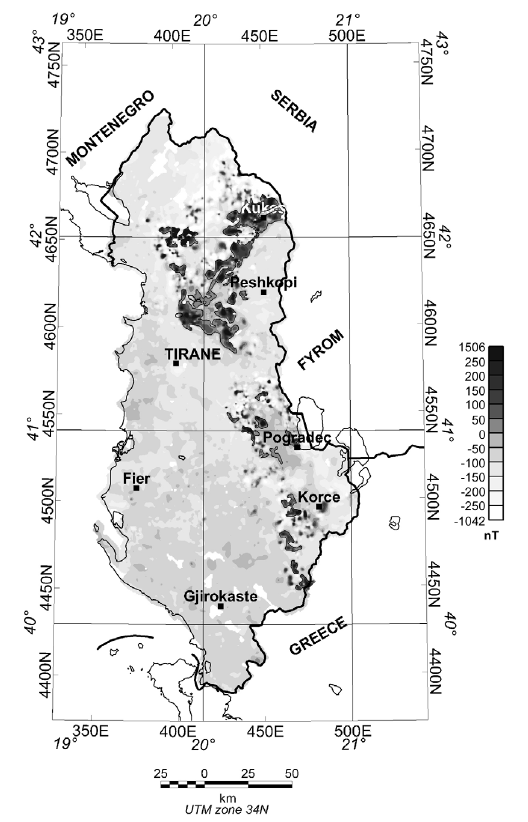
Fig. 5. The residual total magnetic field anomaly map of Albania.